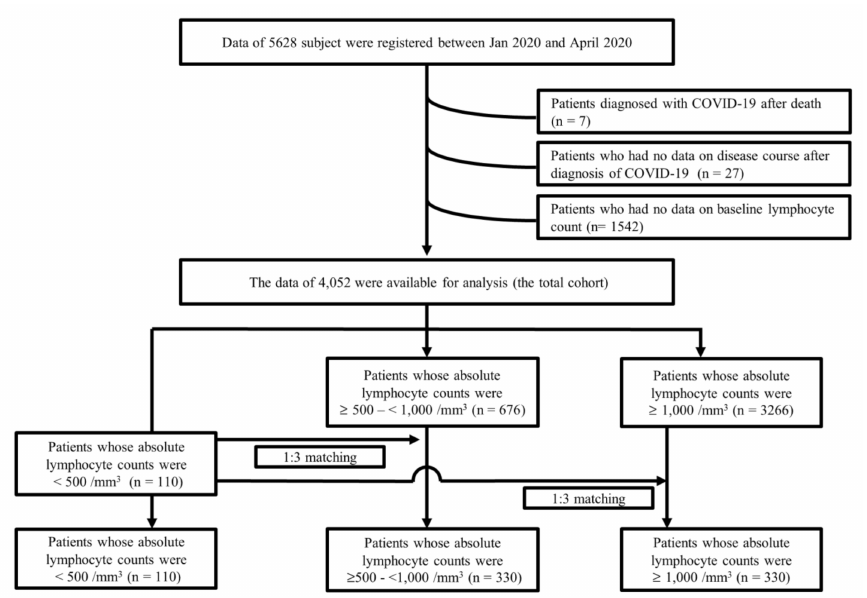
Figure 2. Flow chart showing the disposition of patients according to lymphocyte counts from the Korean nationwide